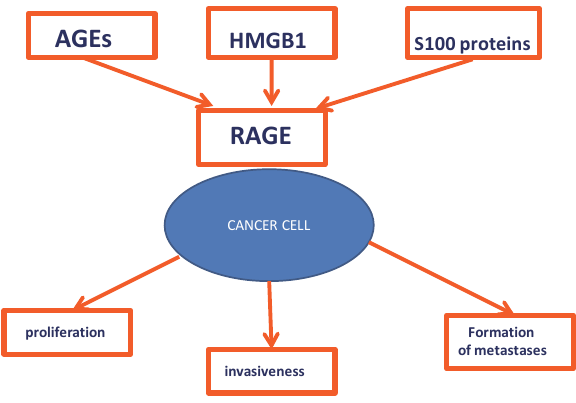
Fig. 1. Activation of RAGE in cancer and its putative conse-